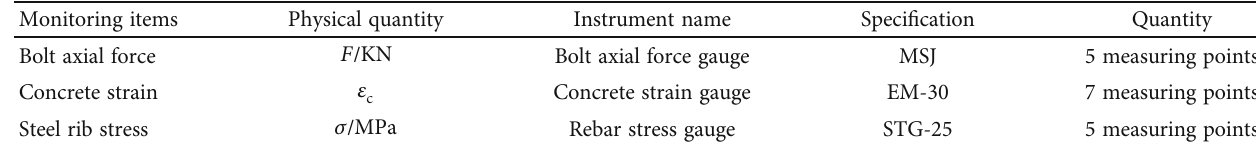
Table 1: Monitoring parameters and instrument